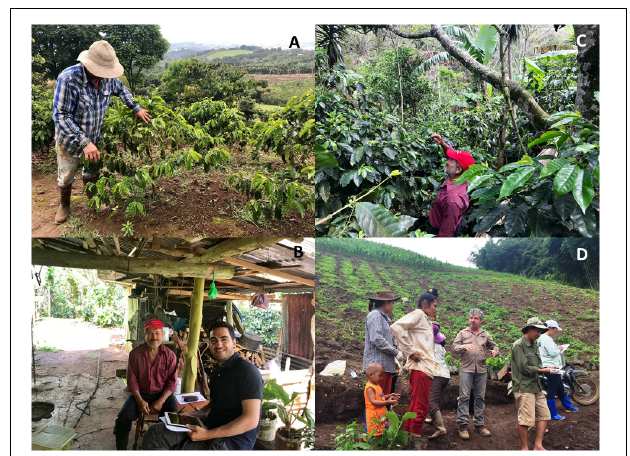
FIGURE 4 | Promoting participatory research and assistance to farmers with new hybrid plant material. (A) Farmer showing “his” Arabica hybrid plants in a farm located in Naranjo at 1300 m a.s.l., Alajuela province, Costa Rica; (B,C) visit of a farmer in San Ramon (1050 m a.s.l.), Alajuela province, Costa Rica; (D) planting of Arabica hybrids in “on farm” evaluation trials in the Sõn La province, Vietnam.